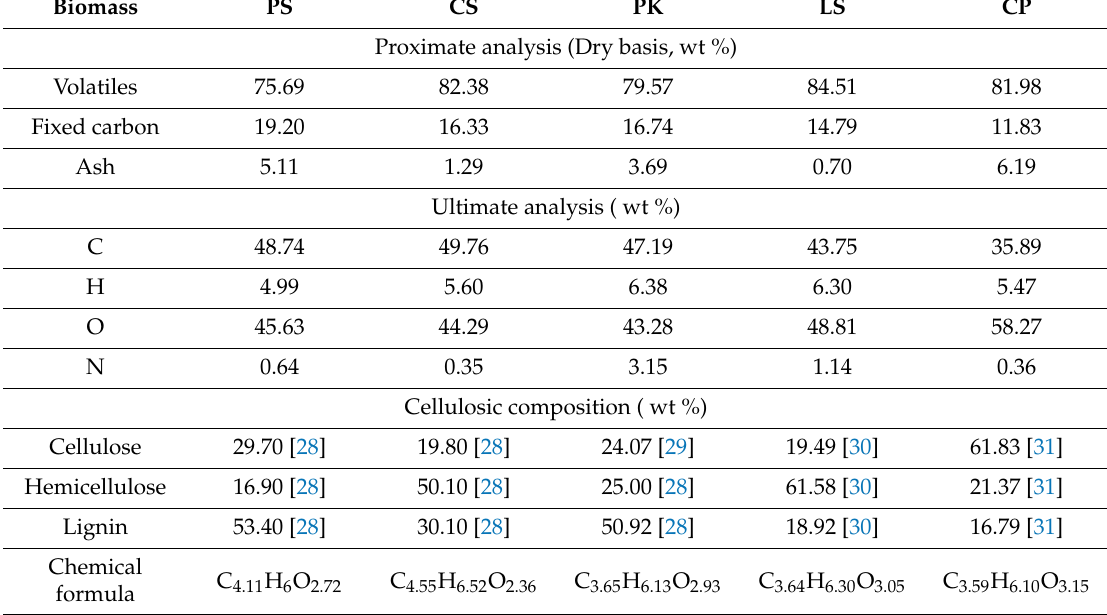
Table 1. Proximate and ultimate analyses of biomass precursors used in the present